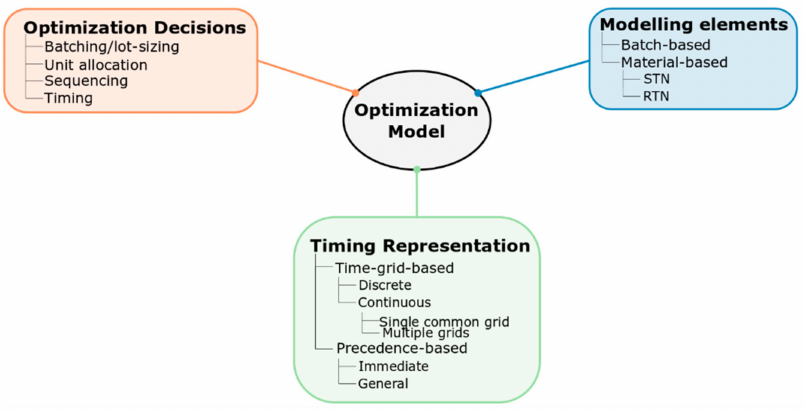
Figure 5. Main aspects of models for optimal production